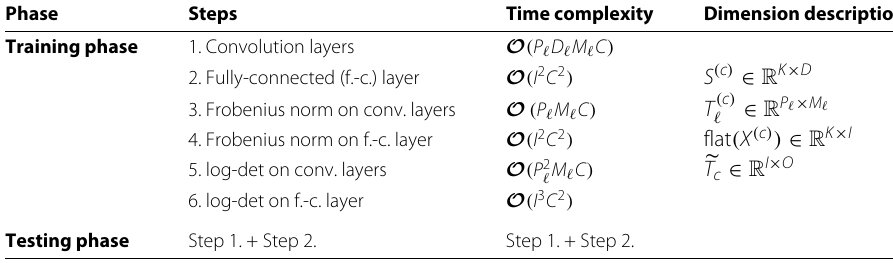
Table 1 Time complexity in training and test phases (for one input sample) Phase Steps Time complexity Dimension description Training